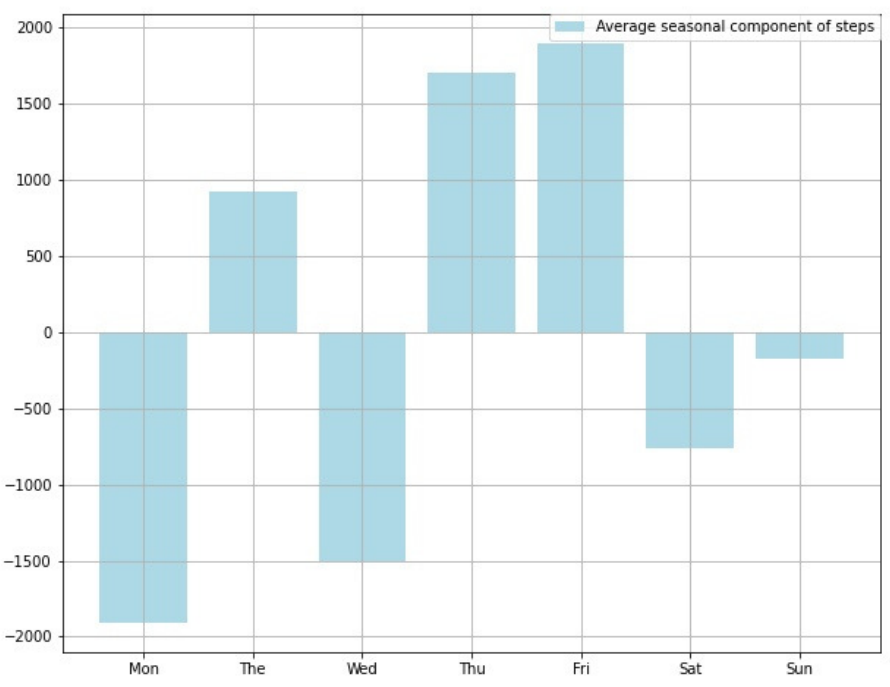
Figure 3. Average seasonal component of